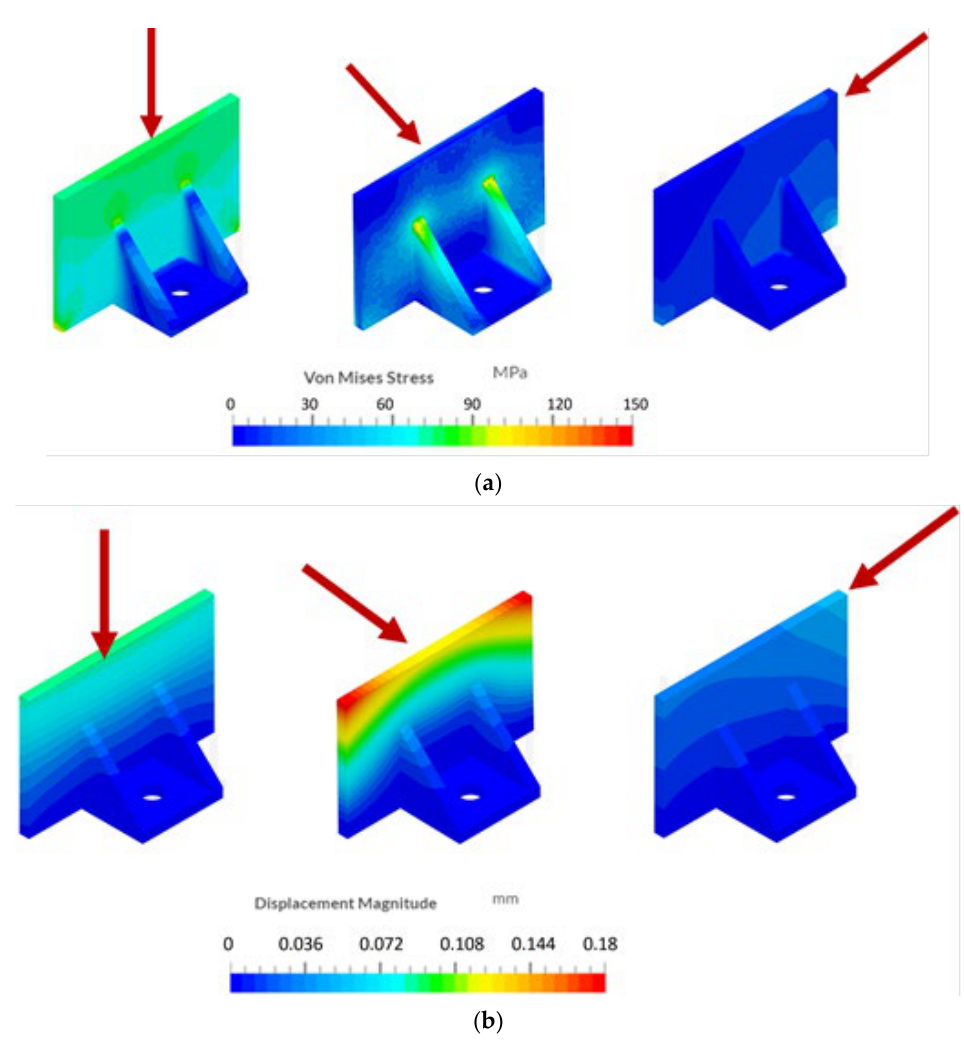
Figure 12. ( a ) Longitudinal deformation. ( b ) Lateral deformation. ( c ) Vertical deformation. The base of the modules is considered as fixed points and load is applied to the module walls.